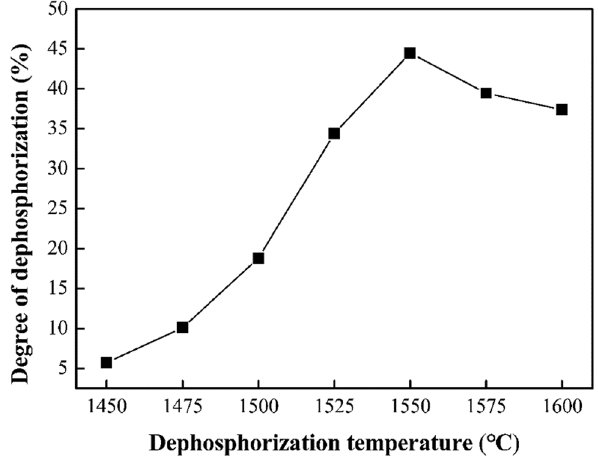
Figure 2: Relationship between dephosphorization e ffi ciency and